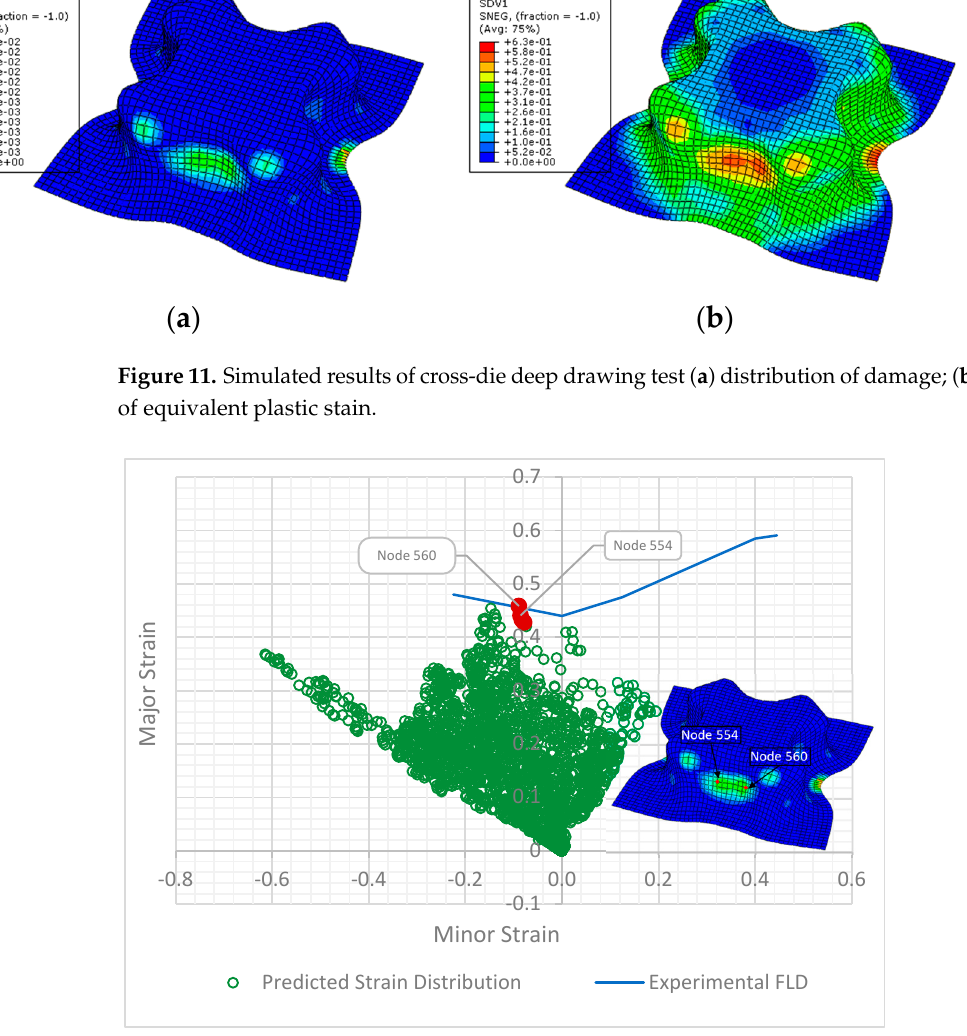
Figure 12. Distribution of strains at different locations.